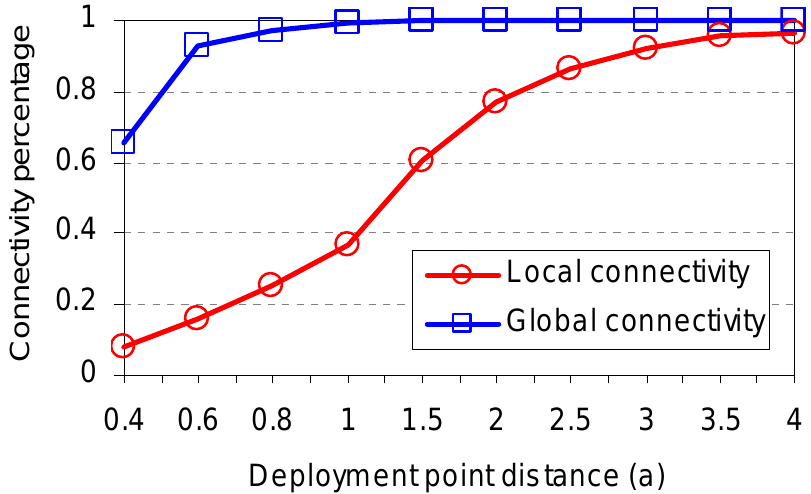
Figure 8. Network connectivity vs. Deployment point distance ( a